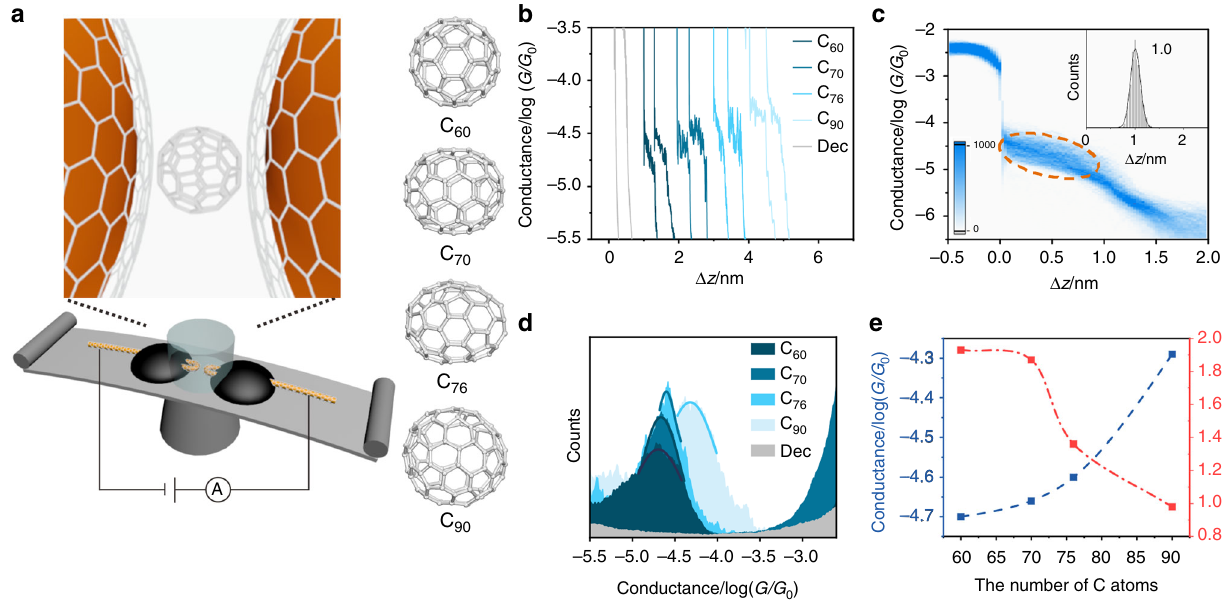
Fig. 1 Conductance measurement of graphene/single-fullerene/graphene junctions. a Schematic of mechanically controlled break junction and graphene/ single-fullerene/graphene junction and chemical structure of C 60 , C 70 , C 76 , and C 90 . b Typical individual conductance – displacement curves for graphene/ blank or single-C 60 , C 70 , C 76 , and C 90 /graphene junctions. c Two-dimensional conductance histogram of single-C 60 junction obtained from ~1700 traces, the high trigger was set as 3.2 × 10 − 3 G 0 ( G 0 is the quantum conductance that equals 2 e 2 / h .) to avoid the damage of the graphene electrodes. The top right inset is the relative displacement distribution ranging from 3.2 × 10 − 4 to 4.0 × 10 − 6 G 0 . d One-dimensional conductance histogram of graphene/single- C 60 , C 70 , C 76 , C 90 /graphene junctions and blank experiments. e Conductance of the graphene/single-fullerene/graphene junctions and the highest occupied molecular orbital – lowest unoccupied molecular orbital gap values of fullerenes vs. the number of carbon atoms in